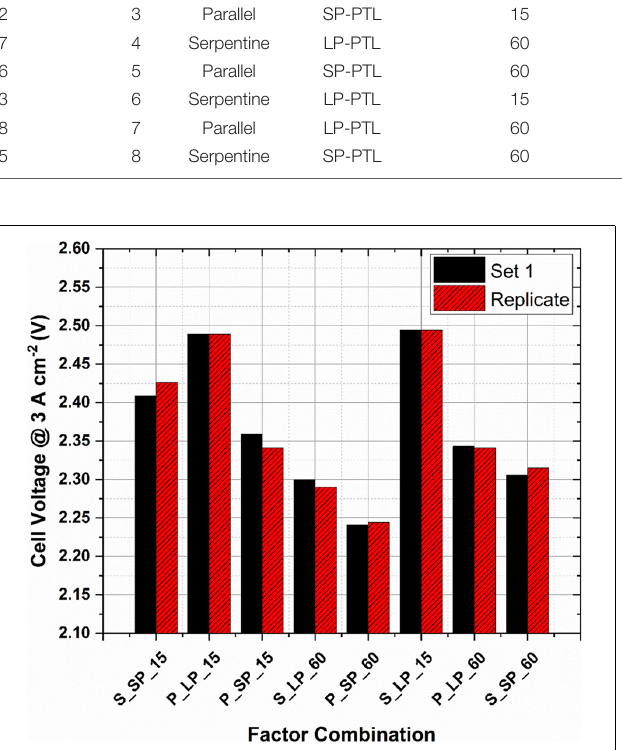
FIGURE 3 | Cell voltage at the various design and parameter combinations (flow-field_PTL_water flow rate) at a constant current density of 3.0 A cm − 2 , operating temperature of 80 ◦ C and ambient pressure.